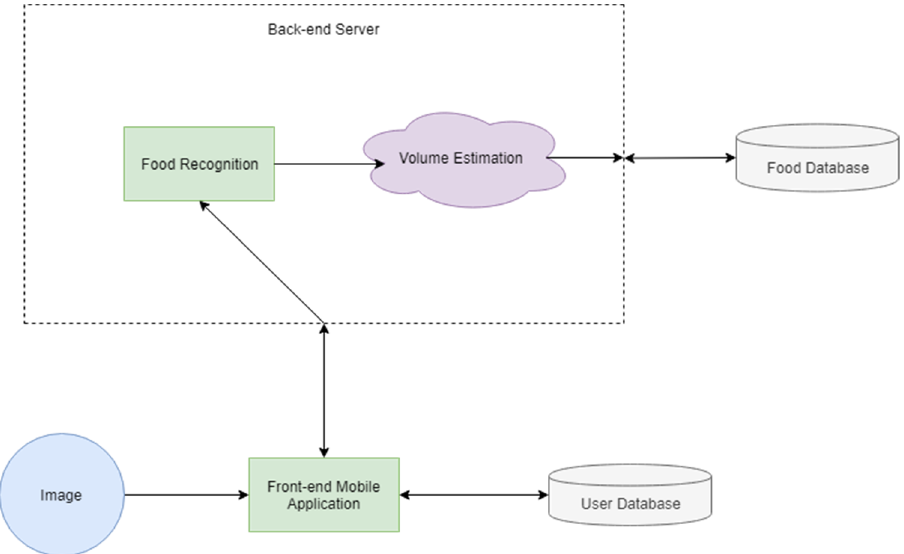
Figure 1. Smart Diet Diary architecture.